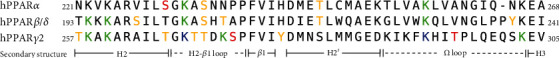
Sequence alignment of the H2-H3 region of the human PPARs, annotated with experimentally observed Ser/Thr/Tyr phosphorylations (red) and Lys acetylations (blue) [152] and with the same PTMs predicted using the tools [147–151] listed in Section 4 (orange and green, respectively). Notably, the employed tools also identified the experimentally observed PTMs.